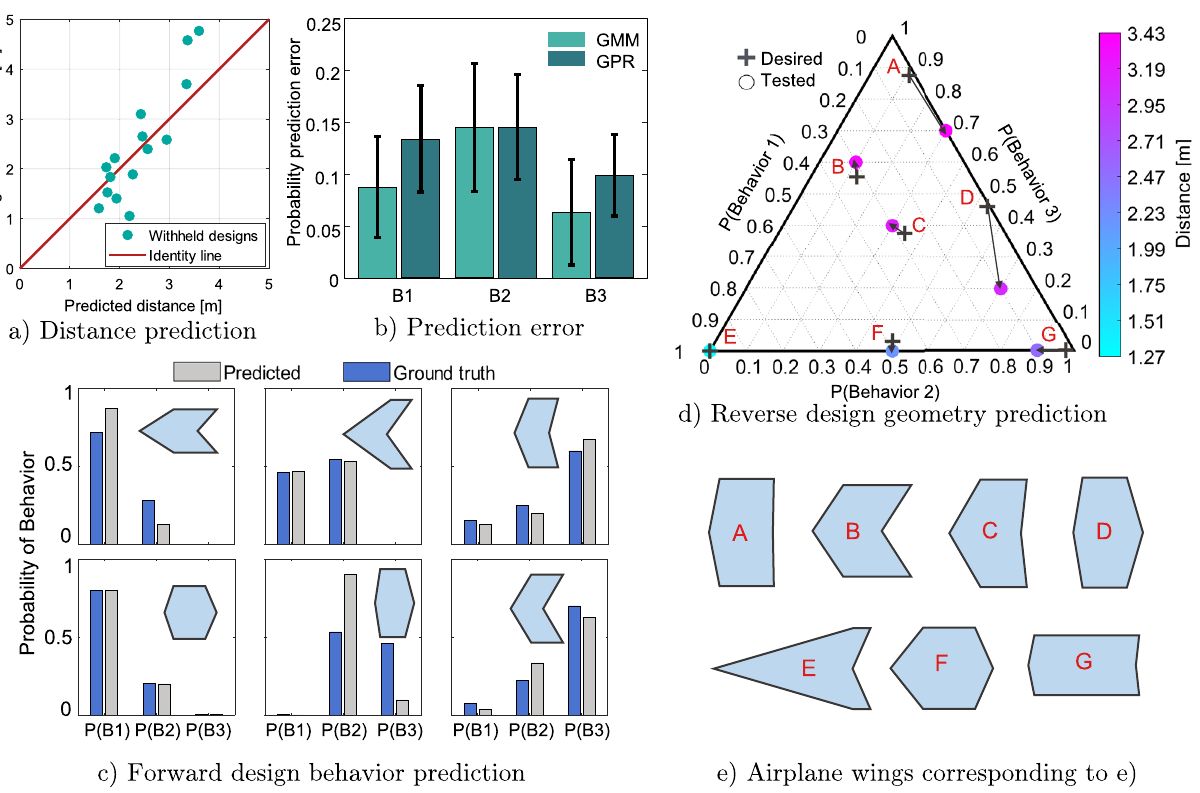
Figure 3. ( a ) Comparison of average actual distance from experimentation to the predicted distance for airplane designs withheld from the model. ( b ) Comparison of absolute average error of probability prediction for all withheld airplane designs between the GMM-assisted method and GPR. ( c ) Forward design behavioral probability prediction of a sample of wings held out from the model compared to its ‘ground truth’ behaviors. ( d ) Reverse design behavior prediction for chosen target probabilities with corresponding average flight distances. ( e ) Airplane geometries that are predicted to display the target behavioral probabilities in reverse